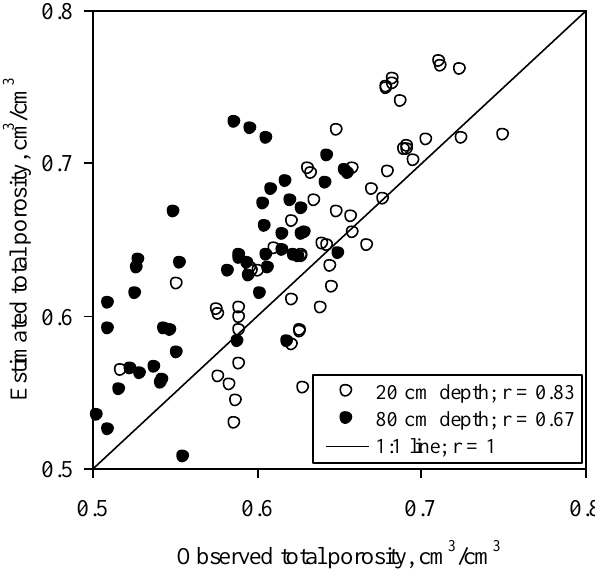
Figure 2. Correlation between the actual total porosity at the two depths (20 and 80 cm) and that estimated from the relationship θ density, and ρ is the particle density (2.65 g cm −3 s